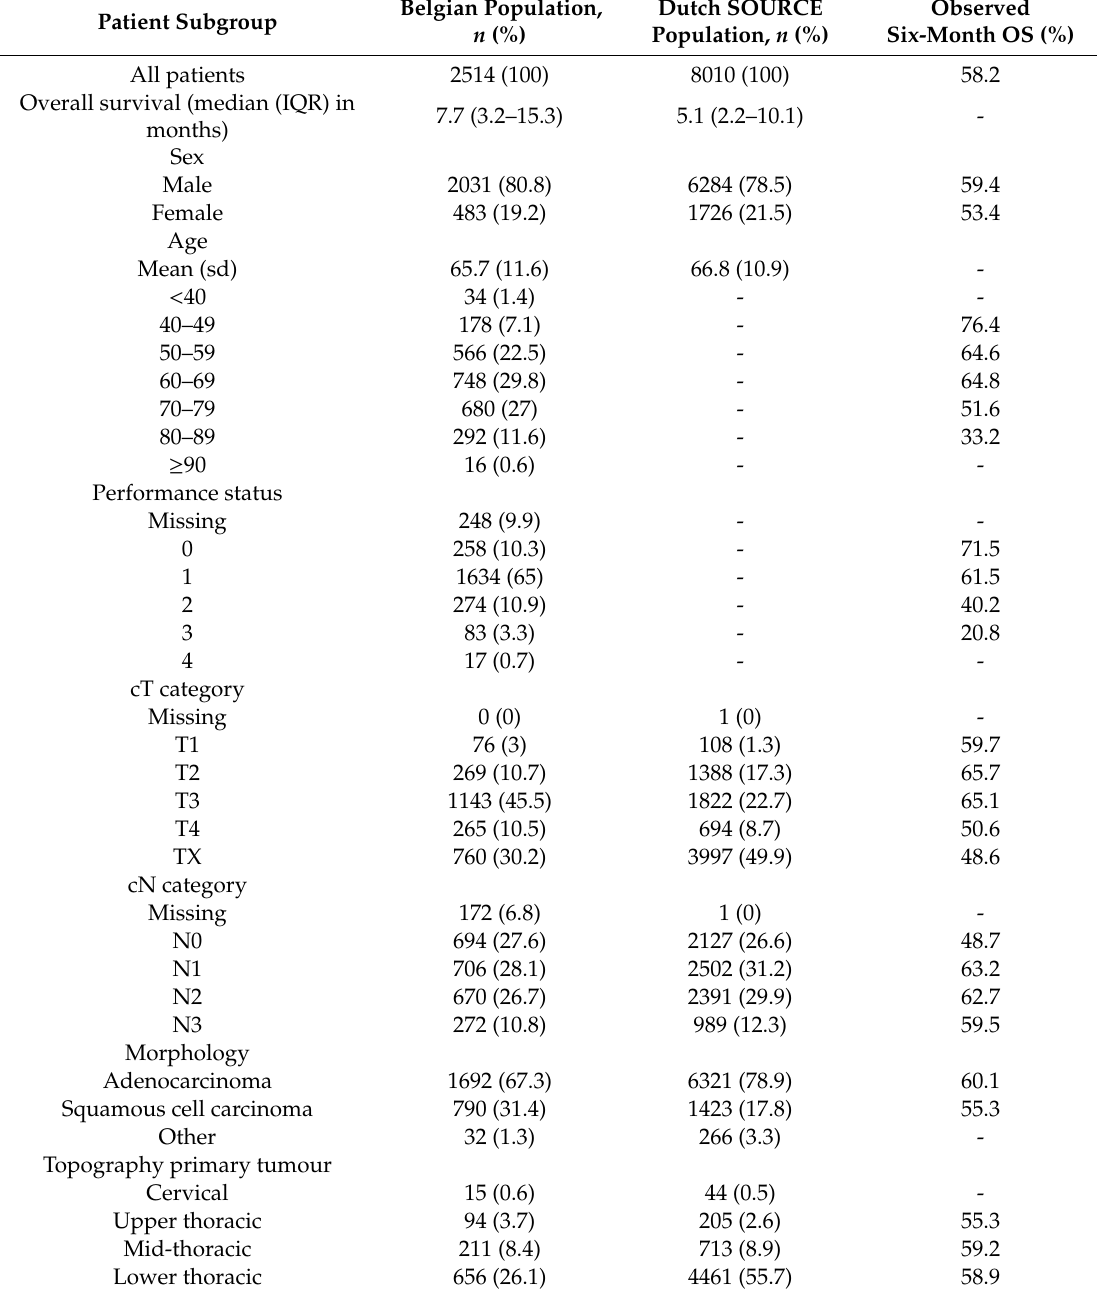
Table 1. Observed six-month overall survival of the Belgian cohort and baseline characteristics of the development (Dutch) and validation (Belgian) oesophageal cancer cohort. NOS: Not Otherwise